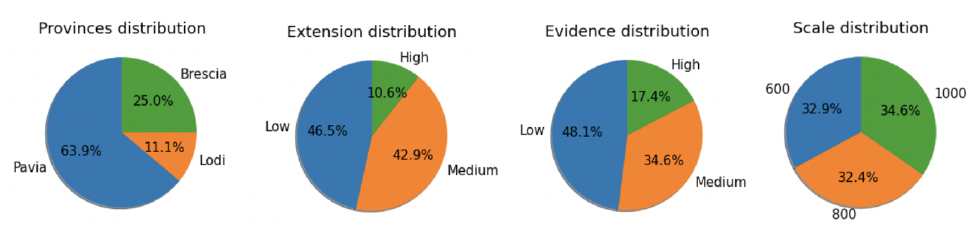
Figure 3. Distribution of the input samples with respect to provenance, extension, and evidence of the visible waste dumps and size of the